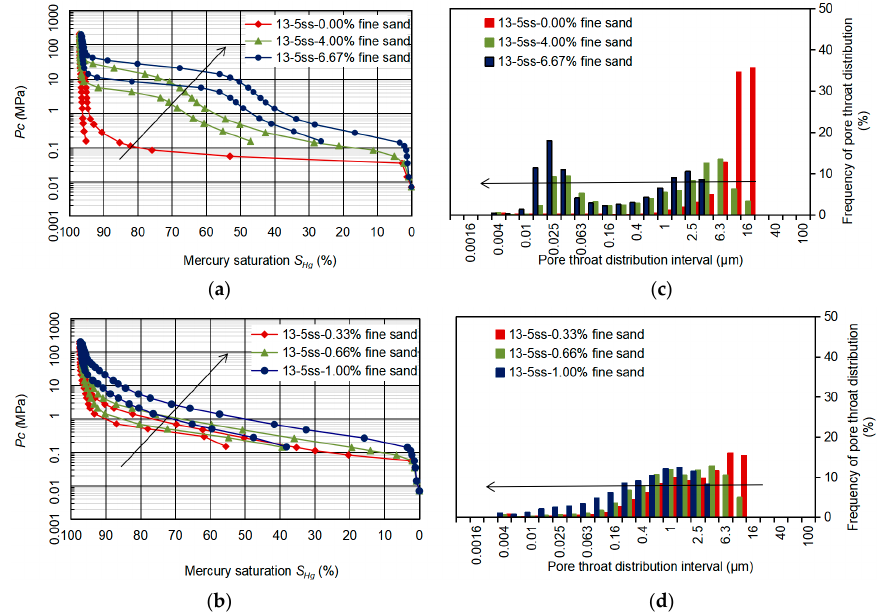
Figure 12. The control of the pore throat size distribution through adjustment of cementation level in the intergranular space with use of fine sands shown by the mercury injection capillary pressure (MICP) testing. On the left hand side are the MICP curve showing an increasing amount of fine sand ratio in the direction pointed by the arrow for two cases. ( a ) A coarser increment of fine sand with 0%, 4%, and 6% fine sand ( ♦ , ▲ , ● respectively); ( b ) A finer increment with an increase of 0.33%, 0.66%, and 1% fine sands ( ♦ , ▲ , ● respectively). ( c , d ) The right-hand side shows the pore throat size distribution derived from the MICP data showing that as the ratio of fine sand increase, the pore throat size distribution ratio move toward the smaller pore throat size.